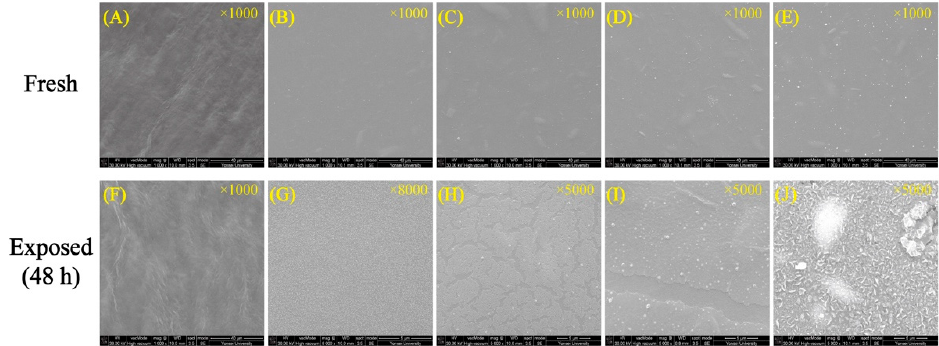
Figure 9. FE-SEM images of fresh ( A – E ) and exposed films to spoilage gas ( F – J ); neat CNC ( A , F ), C-0.22Ag ( B , G ), C-1.12Ag ( C , H ), C-2.25Ag ( D , I ), and C-4.49Ag films ( E , J ).